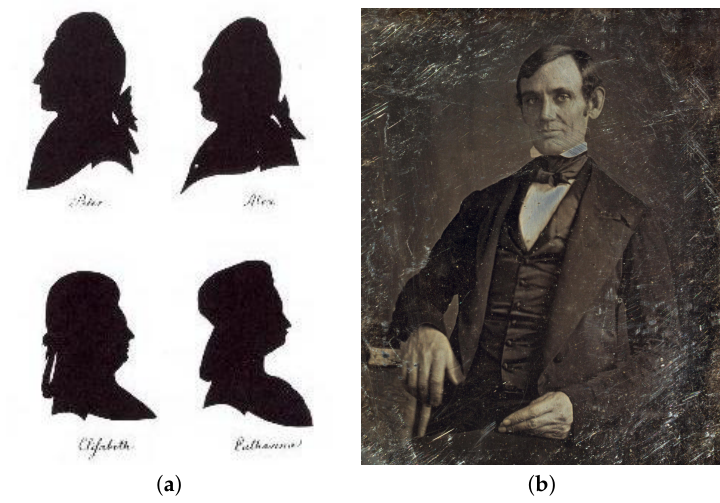
Figure 2. ( a ) A traditional silhouette portrait. ( b ) Daguerreotype portrait of Abraham Lincoln, 1846. Photographic techniques like this completely displaced previous portraiture techniques. Public domain images.